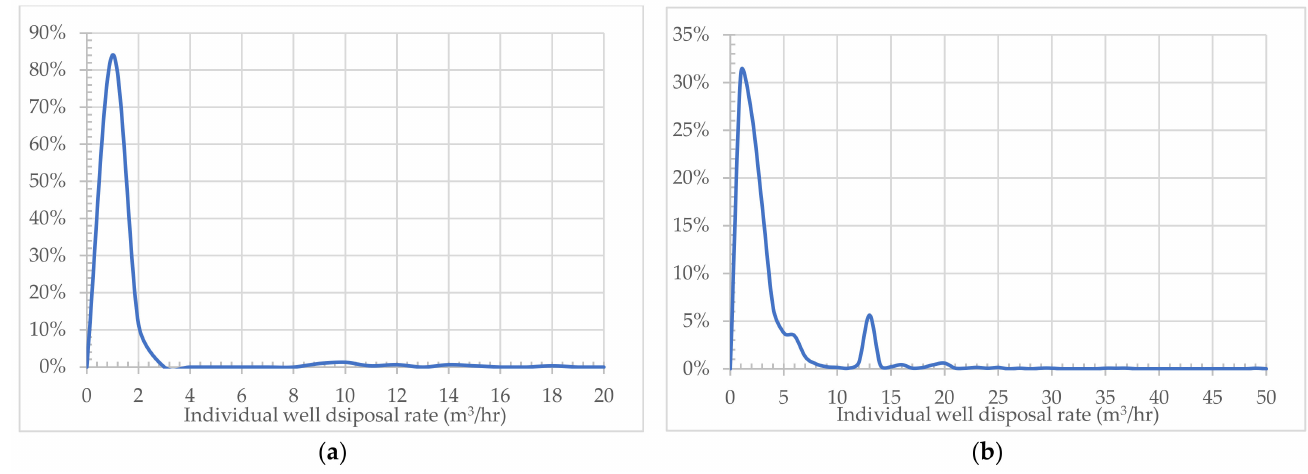
Figure A18. Historical per-well water injection rate ( X -axis) frequency ( Y -axis) distributions (January 1962–December 2022) in ( a ) the Boundary Lake Formation; ( b ) the Charlie Lake